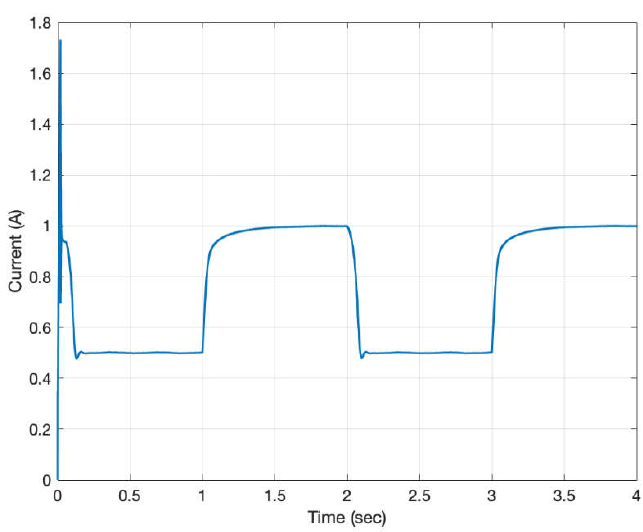
Figure 18. Simulation results for current regulation.